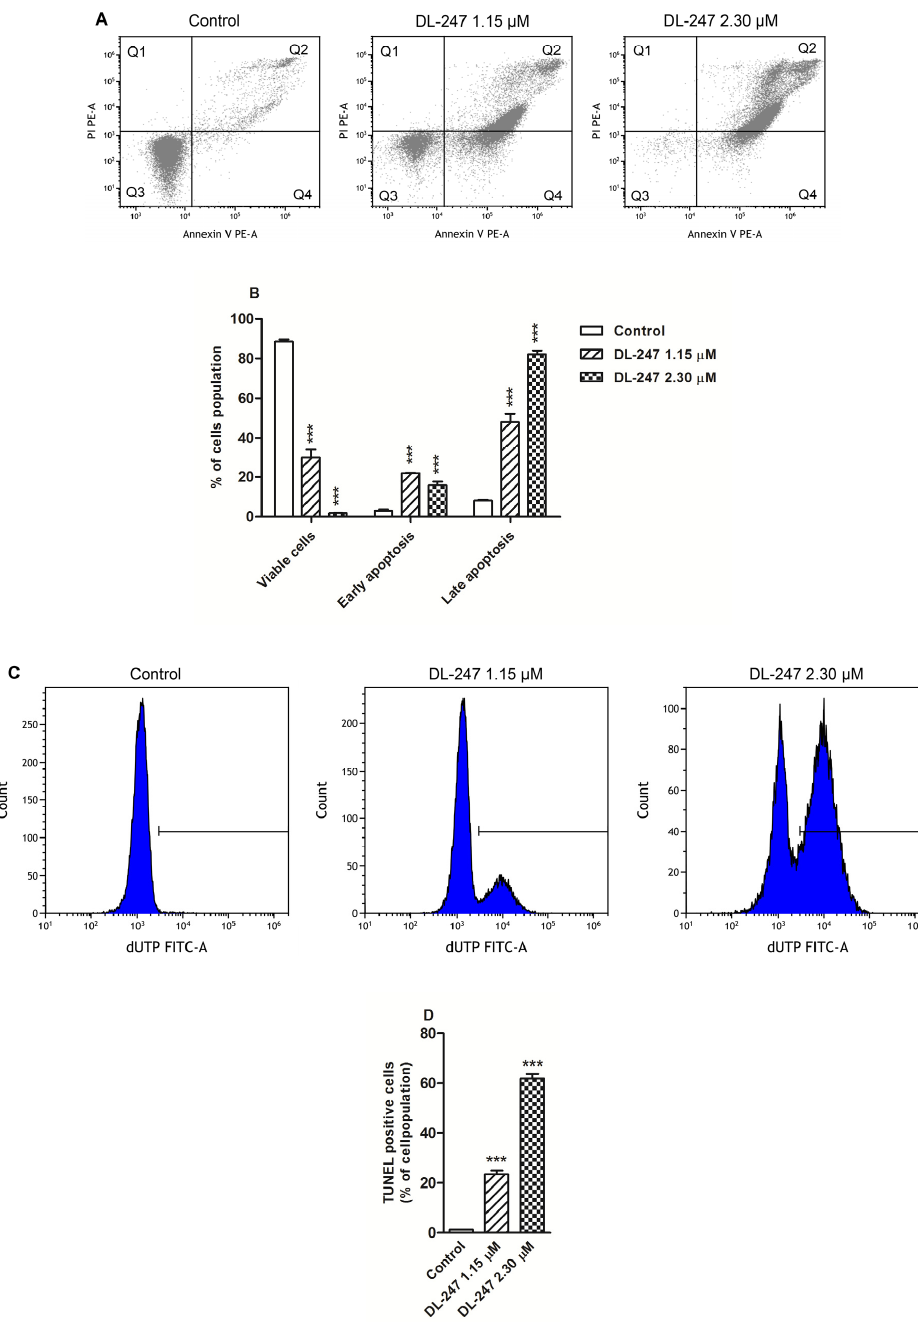
Figure 3. Induction of apoptosis in HL-60 cells treated with DL-247 for 24 h. ( A ) Representative scattered blots of flow cytometry analysis of apoptosis by double-staining with Annexin-V and PI. The percentage of viable cells is shown in quadrant Q3. Quadrant Q4 indicates the percentage of early apoptotic cells (Annexin V-positive cells), whereas quadrant Q2 shows the percentage of late apoptotic / death cells (Annexin V-and PI-positive cells). ( B ) Quantitative analysis of apoptotic cell death by Annexin V and PI assay. ( C ) Representative histograms of flow cytometry analysis of DNA fragmentation measured by TUNEL assay. ( D ) Quantitative analysis of DNA fragmentation. ( B , D ): Data are presented as mean ± SEM of three independent experiments. Statistical significance was assessed using one-way ANOVA and a post-hoc multiple comparison Student–Newman–Keuls test. *** p < 0.001 vs.